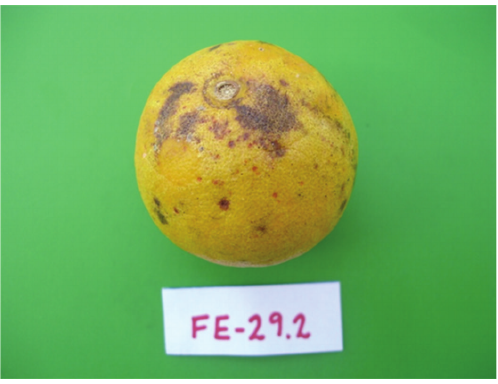
Figure 4: Aspect of fruit inoculated with G . citricarpa isolate showing the characteristic symptoms of